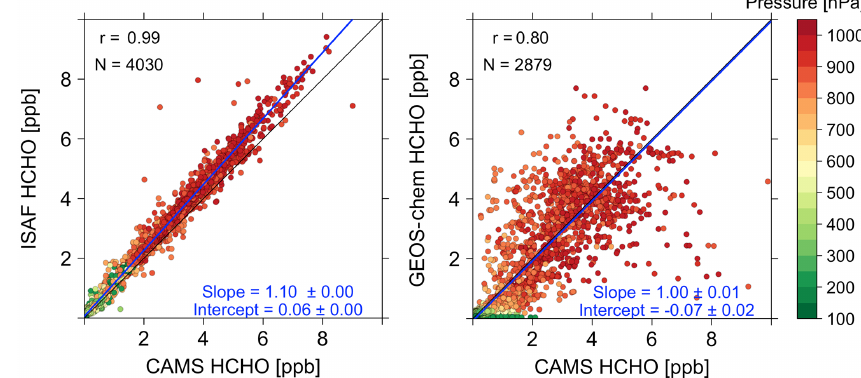
Figure 2. Comparisons between HCHO measurements from the CAMS and ISAF instruments aboard the SEAC 4 RS aircraft, and simulated by GEOS-Chem, for the southeast US flight tracks (box in Fig. 1). The left panel compares 1min measurements from CAMS and ISAF. The right panel compares GEOS-Chem and CAMS HCHO. Here and elsewhere for model–observation comparisons, HCHO observations along the flight tracks are averaged onto the GEOS-Chem grids (0.25 ◦ × 0.3125 ◦ , 47 vertical layers) and time steps (10min). HCHO data points are colored by atmospheric pressure. Slopes and intercepts of reduced major axis (RMA) regressions are shown along with the correlation coefficient ( r ), sample size ( N ), RMA regression line (in blue) and 1 : 1